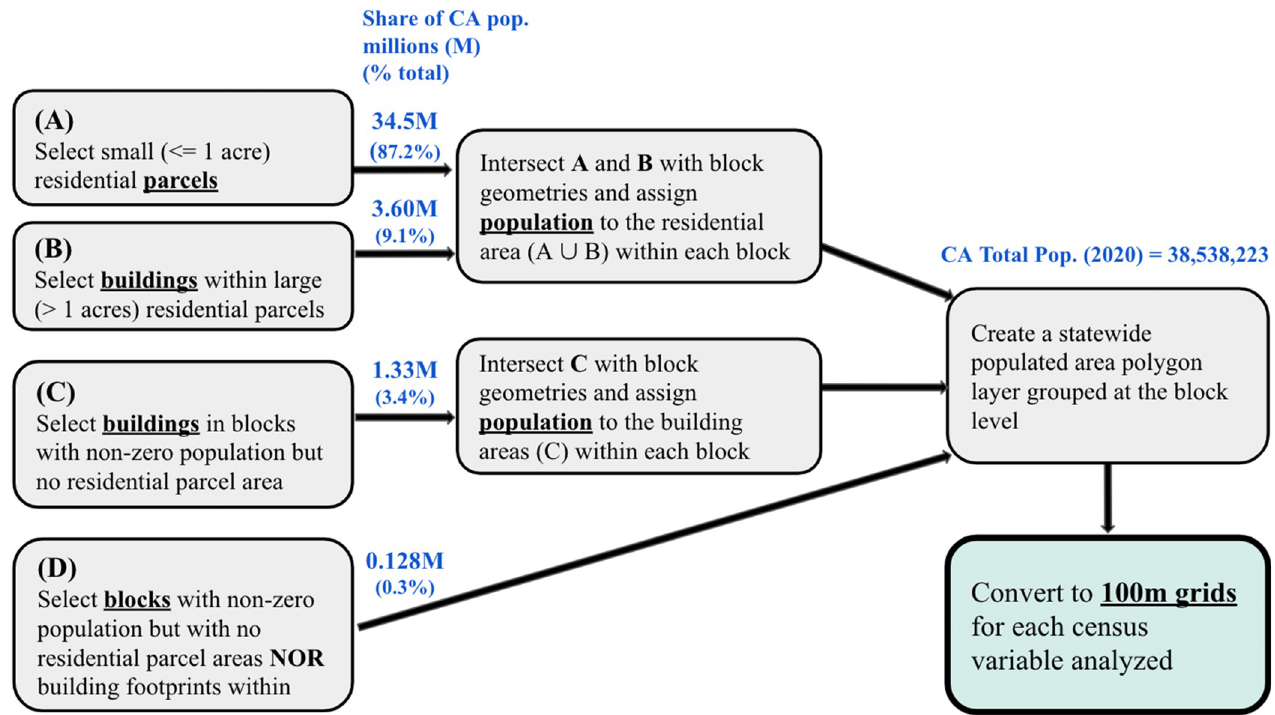
Fig 3. Process workflow illustrating the identification of population target zones. Dasymetric mapping process using the residential parcel and building footprint ancillary datasets within each census block and producing the final statewide grids for each population variable considered.